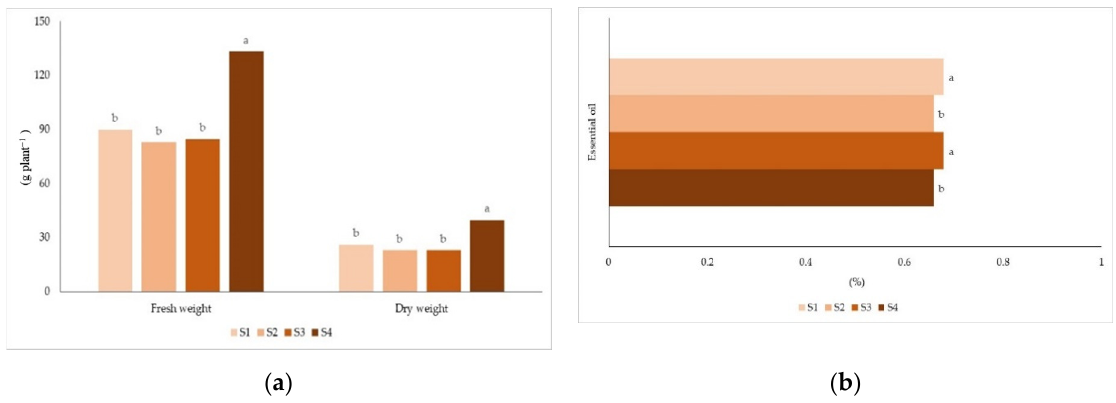
Figure 5. Effect of substrate on production characteristics of rosemary biotypes. Graph ( a ) refers to effect of substrate on fresh and dry weight, while graph ( b ) refers to effect of substrate on essential oil. Means followed by the same letter are not significantly different for p ≤ 0.05 according to Tukey’s